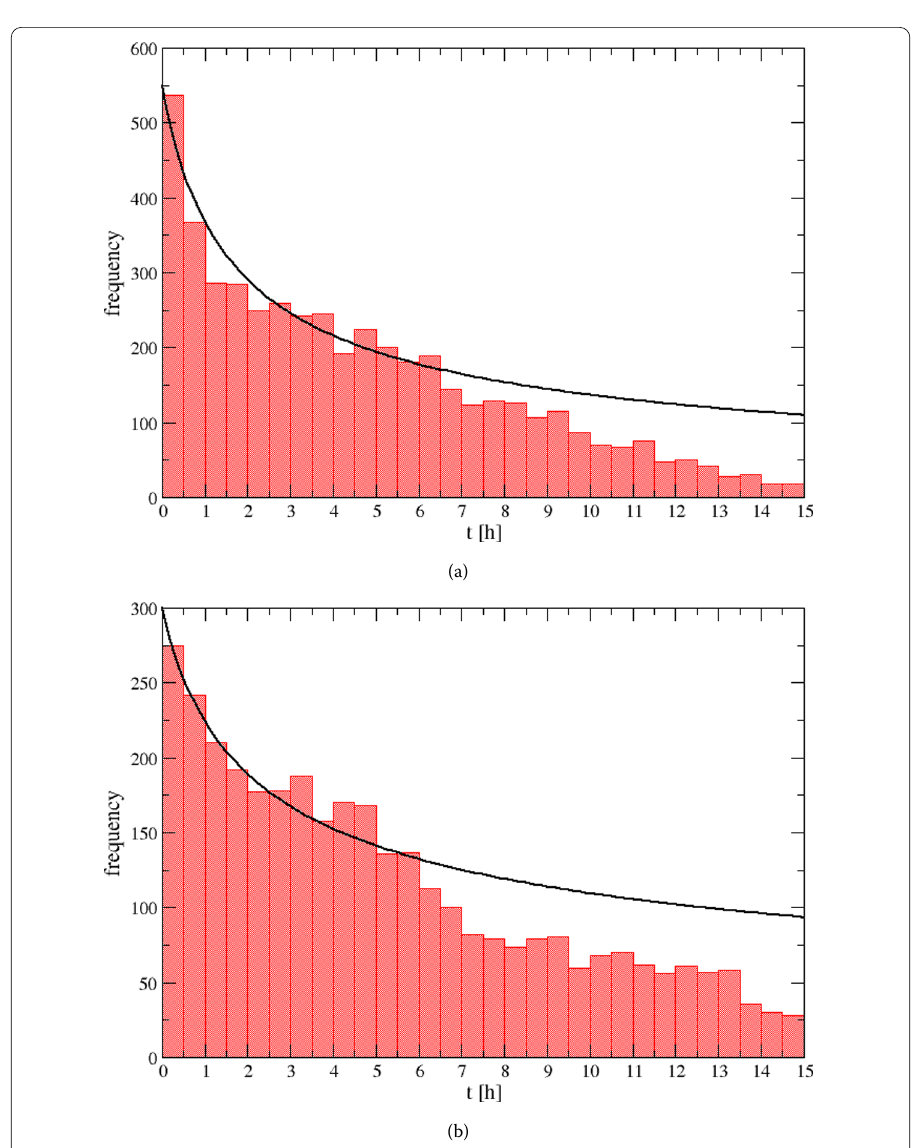
Figure 7 Interpolation of the empirical elapsed time distributions by using the analytical distribution (4) the left picture refers to the Carnival dataset, whereas the right picture to the FestadelRedentore dataset. The continuous line is the distribution (4) with parameter α = 0.42, τ = 1 in the first case and α = 0.58 and τ = 1